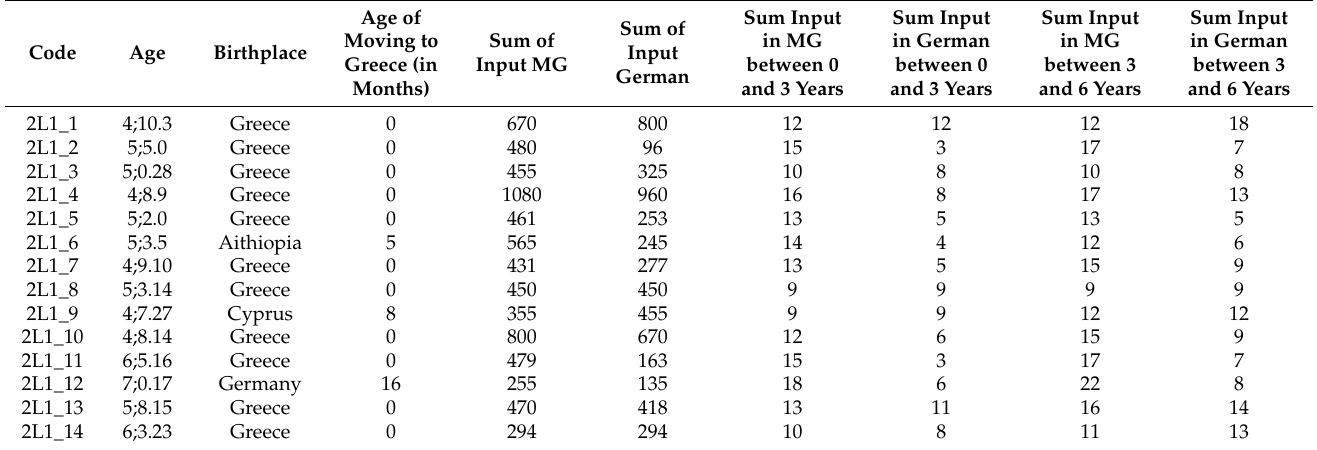
Table 5. Demographic and language background characteristics of the 2L1 participants (age, birth- place, age of moving to Greece, language input and output in each language and sum of input in the first 6 years).